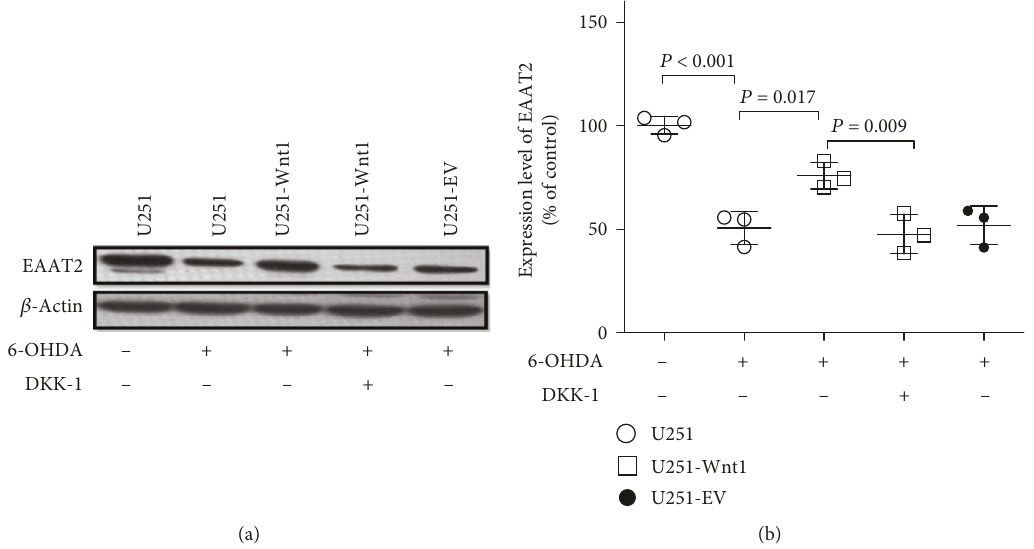
Figure 7: Wnt1 overexpression attenuated the inhibitory e ff ect of 6-OHDA on EAAT2 expression in U251 cells. U251 cells, U251-Wnt1 cells, or U251-EV cells were treated with vehicle, 6-OHDA (50 μ M), or/and DKK-1 (100ng/ml) for 24 h, and the protein levels of EAAT2 (a) were detected by Western blot with β -actin as an internal control. The relative band intensities of EAAT2 (b) were measured by Quantity One software and normalized to the expression of β -actin. Di ff erences among groups were examined using ANOVA followed by using Tukey- Kramer tests for post hoc multiple comparisons. Data are presented as the mean ± SD of 3 experiments. F value = 25.29, df = 10 , and df = 14 . df withingroups total